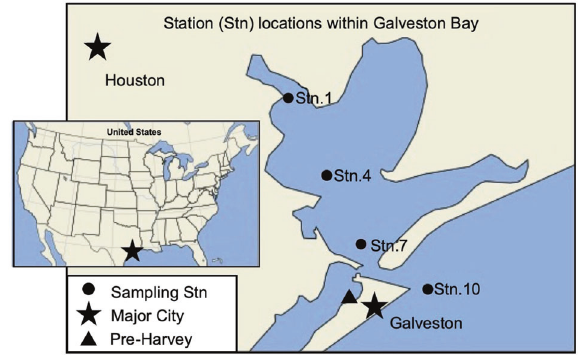
Fig. 1 Sampling map of Galveston Bay, Texas (United States) showing the sampling stations (Stn) used during each of the sampling efforts. The triangle represents the Texas A&M University at Galveston boat basin where pre-Harvey samples were taken on July 31 and August 22 of 2017. Sampling trips always started in the morning and transited from Station 1 to Station 10 from the mouth of the San Jacinto River to the Gulf of